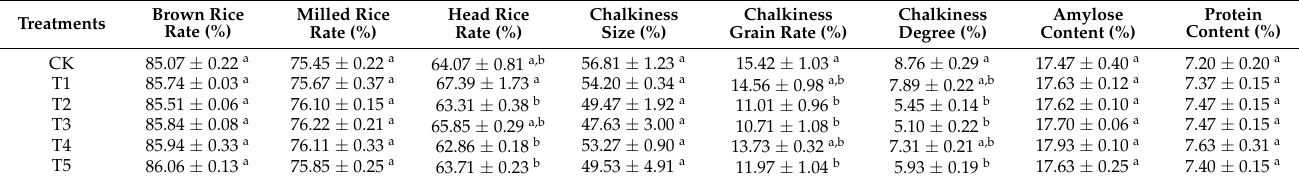
Table 6. Rice quality under different ZnO NPs application amounts.